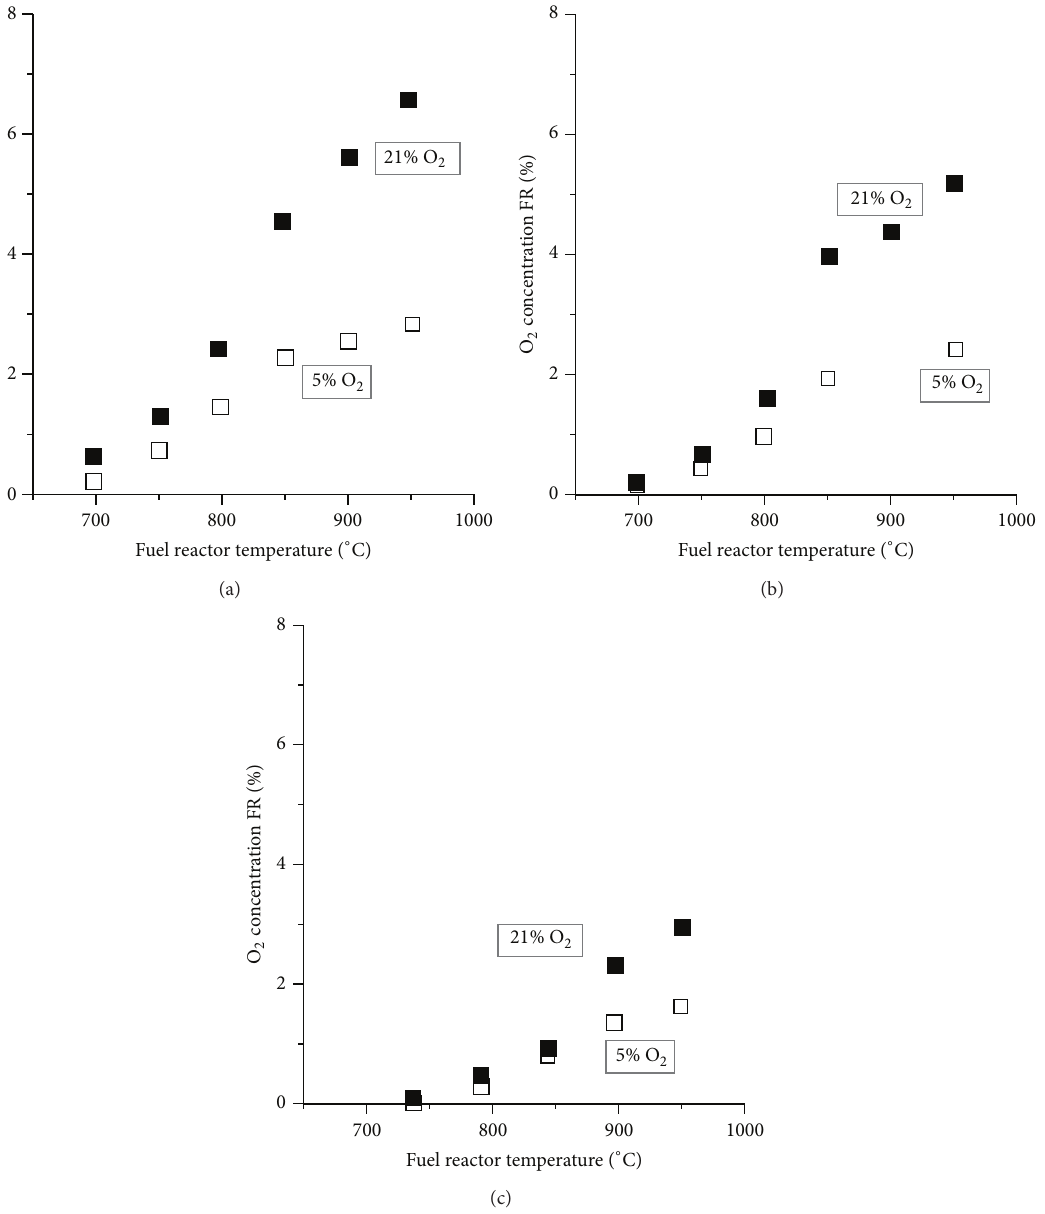
Figure 3: Effect of temperature and AR O 2 concentration on oxygen uncoupling for CaMn 0.8 Mg 0.2 O 3−𝛿 (a), CaMn 0.9 Mg 0.1 O 3−𝛿 (b), and CaMn 0.775 Mg 0.1 Ti 0.125 O 3−𝛿 (c). The oxygen concentration is corrected through